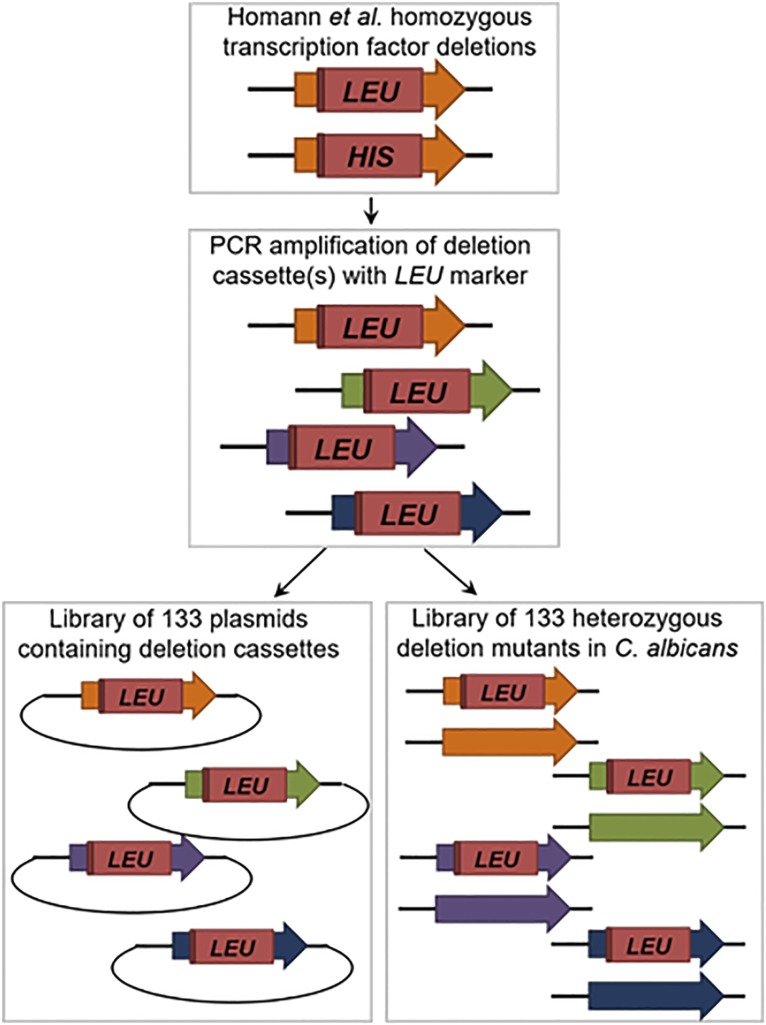
Schematic for construction of heterozygous transcription factor deletion library and LEU2-marked deletion cassettes.